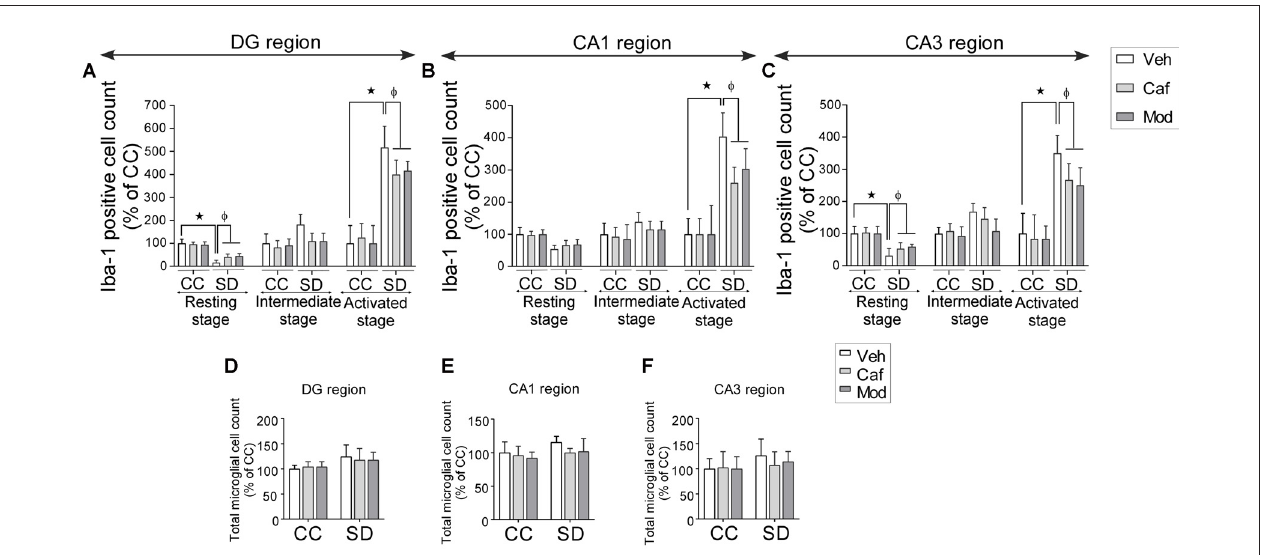
FIGURE 7 | Caffeine or modafinil improved the microglial cell numbers following SD. Changes in the microglial cell count at different stages (resting, intermediate and activated) in (A) DG region; (B) CA1 region; (C) CA3 region of the hippocampus. Total microglial cell count in (D) DG region; (E) CA1 region; (F) CA3 region of the hippocampus. ∗ p < 0.05 when compared to control treated with vehicle; φ p < 0.05 when compared to sleep deprived treated with vehicle. Two way ANOVA followed by Tukey post hoc test with multiple comparison was applied for statistical comparison between groups and for the graphical representation, values expressed mean percentage of Control ±